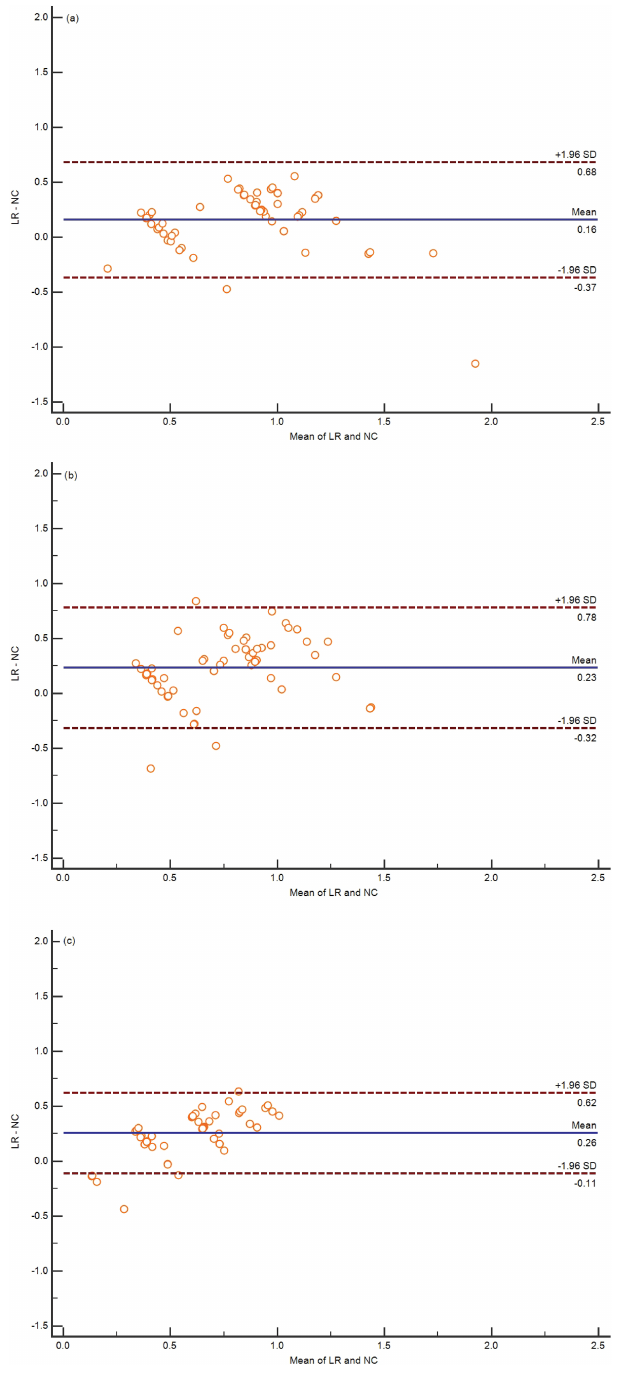
Figure 7. Bland–Altman plots for different flooding events in (a) 2005, (b) 2009 and (c) 2012. These graphs show differences between water depth provided by neighbourhood chiefs (NC) and local representatives (LR) in metres against averaged values of NC and LR. Blue line is the mean difference value, and the red dotted lines show the ± 1 . 96 standard deviation (SD) water depth differ- ences for all